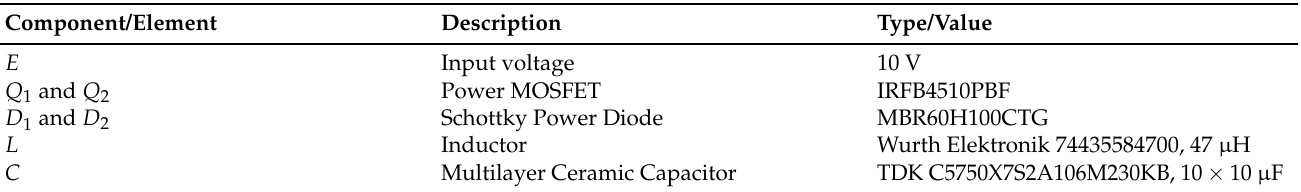
Table 2. Components description of the reconfigurable power converter